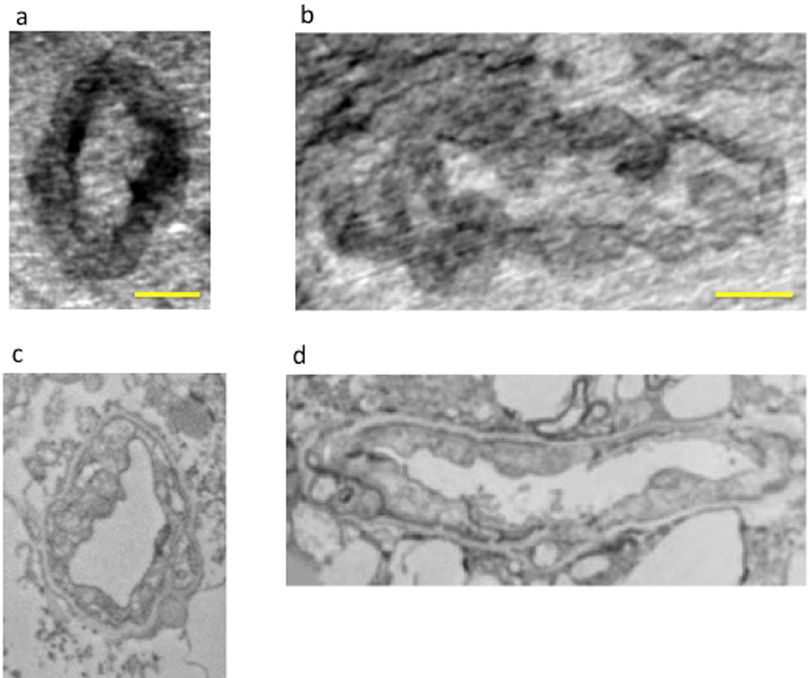
Figure 2. Comparison of naïve mouse CNS vessel imaging by nano-XPCT and TEM. Transversal and longitudinal sections of a capillary in naïve mouse spinal cord by nano-XPCT (( a , b ) respectively) and TEM (( c , d ) respectively). The thickness of the virtual slice selected by XPCT was 130 nm; the thickness of the slice analyzed by TEM was 120 nm. Scale bar = 8 μ